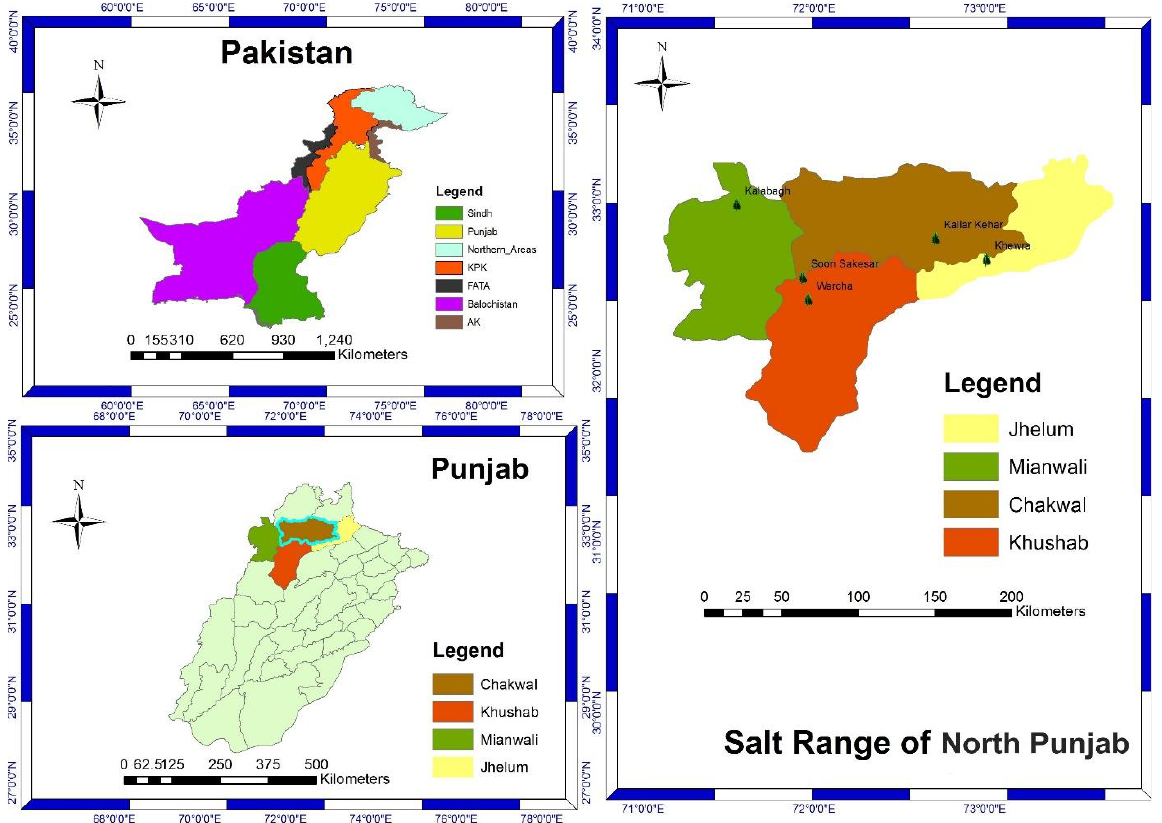
Figure 7. Map of the study area.